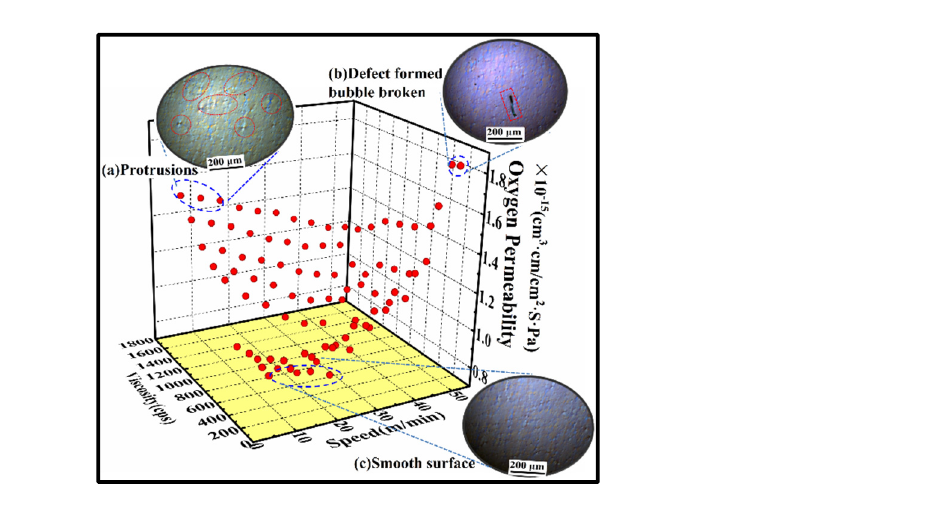
Figure 9. Effect of coating speed and copolymer solution viscosity on barrier properties of coated PET films. ( a ) Protrusions; ( b ) defect formed and bubble broken; ( c ) smooth surface.